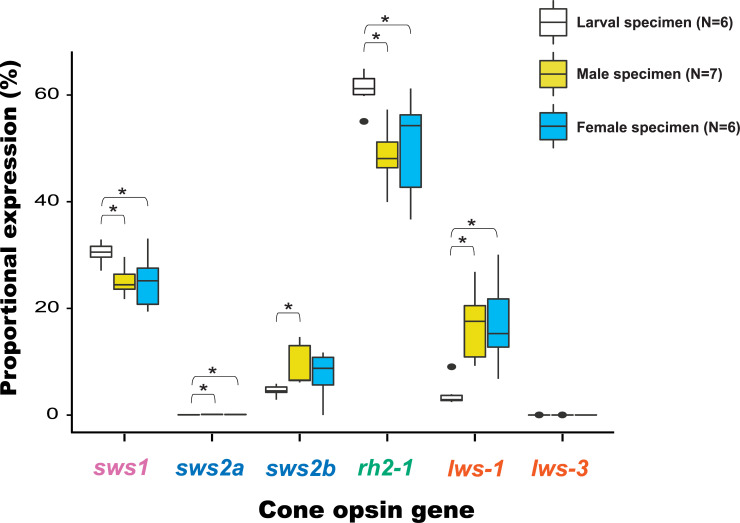
Box-plot showing the median (—), 25th and 75th percentiles (box), 95% range (|), and outliers (•) of cone opsin proportional expression values for adult and larval specimens.An asterisk (*) indicates p < 0.05.